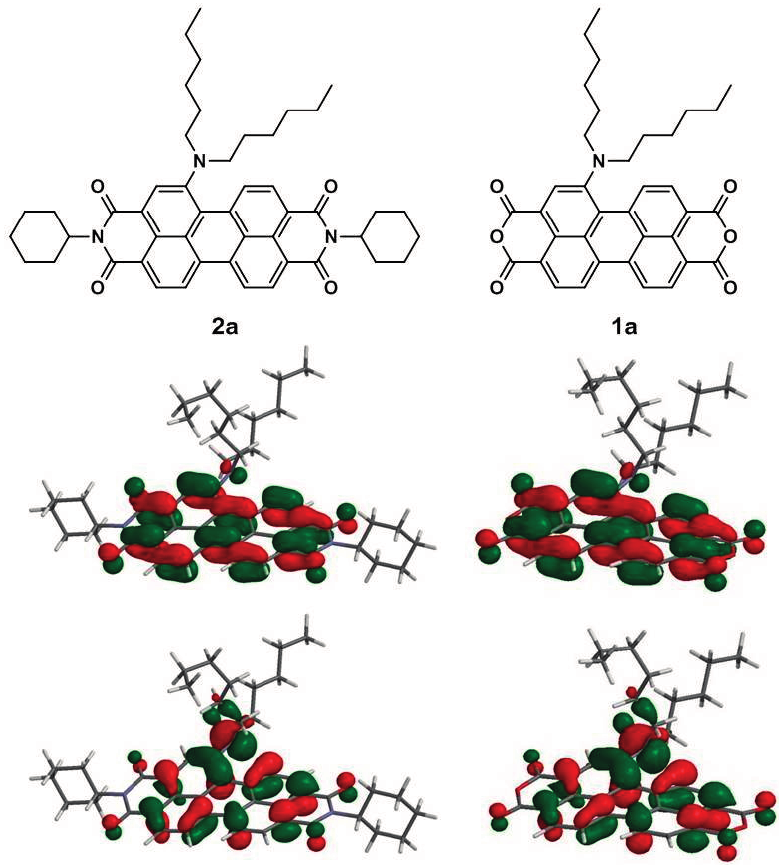
Figure 7. Computed frontier orbitals of 1a and 2a . The upper graphs are the LUMOs, and the lower ones are the HOMOs.